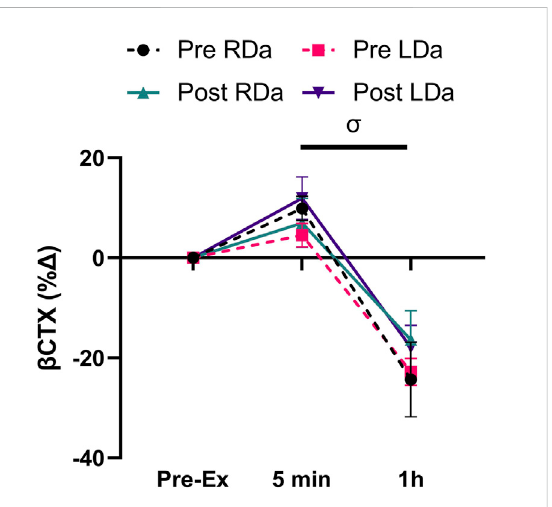
FIGURE 3 Serum C-terminal telopeptide of type 1 collagen ( β CTX) percent change to acute exercise at pre- and post-intervention in bothRDaandLDagroups:percentchangeofserum β CTXat5 min and 1 h post-exercise relative to pre-exercise in both RDa ( n = 14) and LDa ( n = 16) groups. σ = main effect for time ( p < 0.05) independent of intervention or group. Data are reported as mean ±